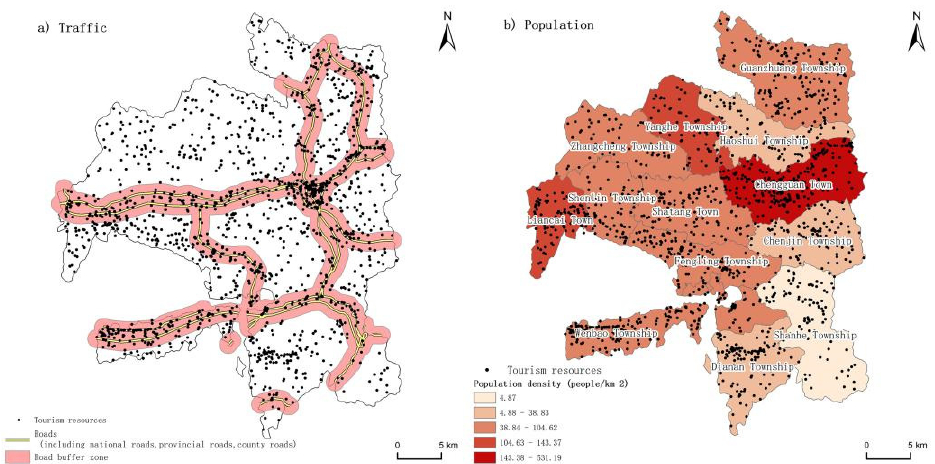
Figure 8. The relationship between the distribution of tourism resources and the social environment. Data source: the Statistical Bulletin of National Economic and Social Development and the National Basic Geographic Information System database.